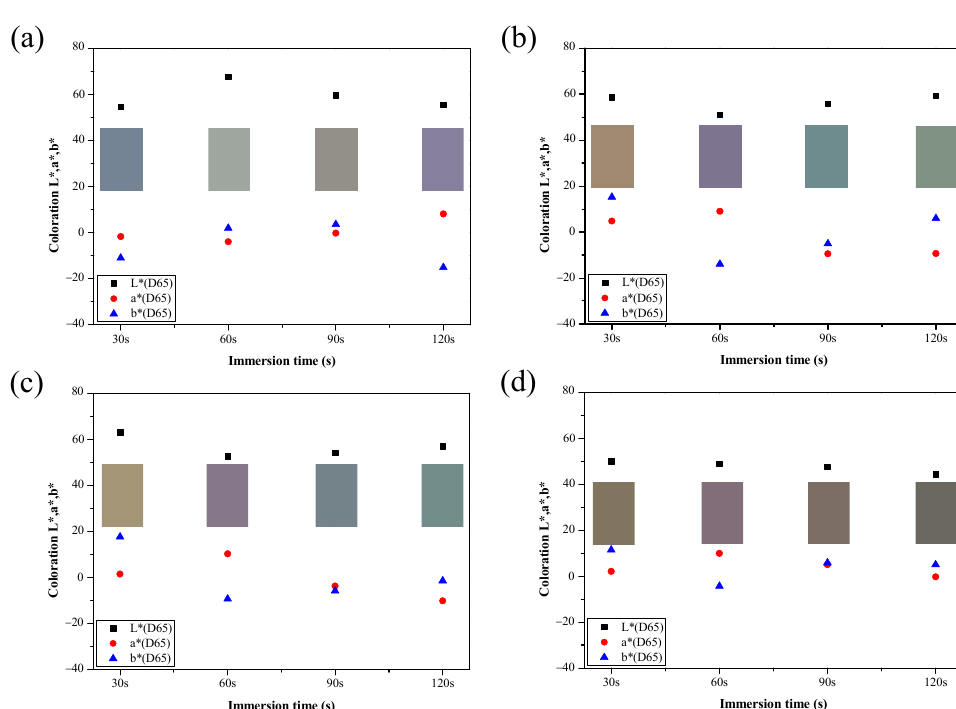
Figure 9. Graphical representations of SCE L *(D65), a *(D65), and b *(D65) values and SCE colors at different immersion times for Zn–Ni alloy plating at different NaF concentrations: ( a ) NaF 0%, ( b ) NaF 50%, ( c ) NaF 100%, and ( d ) NaF 150%.